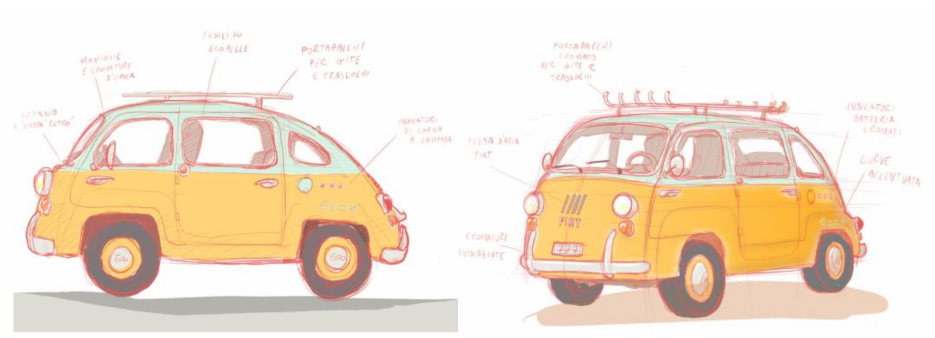
Figure 20. Sketches FIAT 600 Omega: Stone Design.